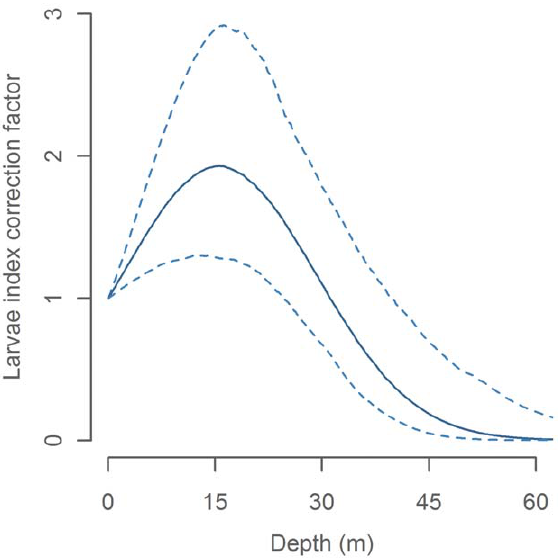
Figure 4. Catchability effect of thermocline depth on CPR larvae